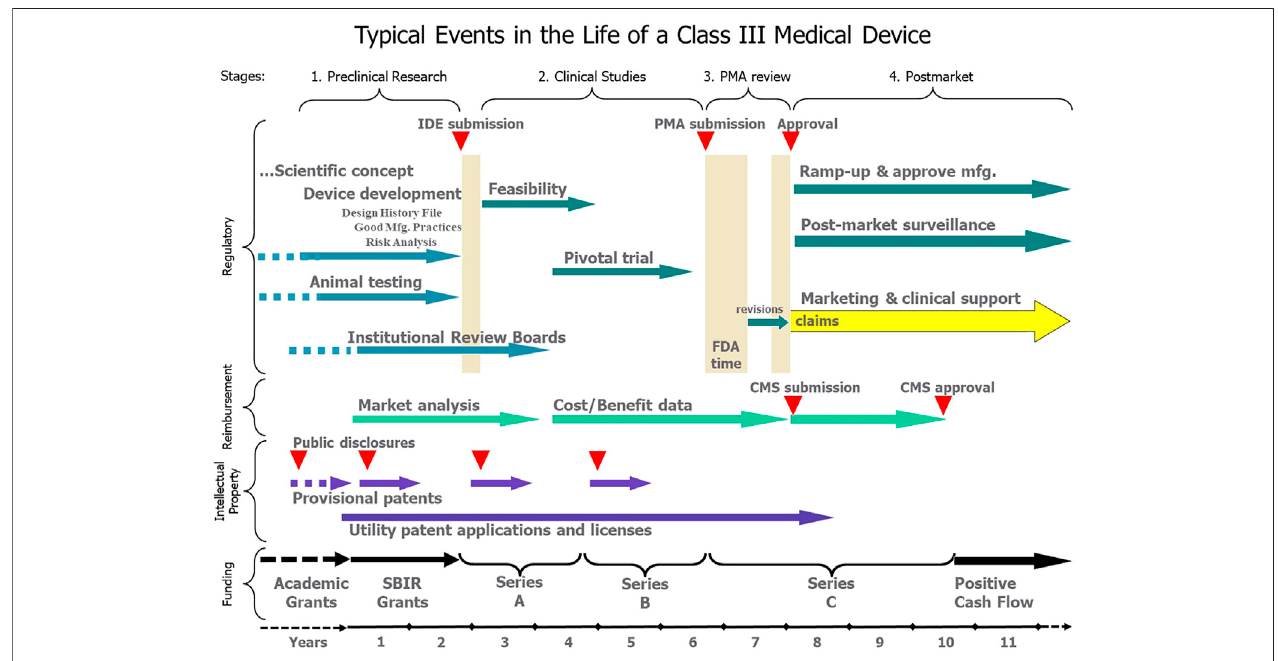
FIGURE 1 | After an indeterminate number of years of funding and development as an academic project (dashed lines), the typical transition to a commercial product can be divided into four stages, each of which involves teams of non-technical personnel for Regulatory, Reimbursement, Intellectual Property and Funding activitiesoveraperiodofyears.Alltheseactivitiesshouldbefocusedontheapprovedclaimsthateventuallyprovidethebasisformarketingandrevenuefromsalesofan approved, reimbursed and protected